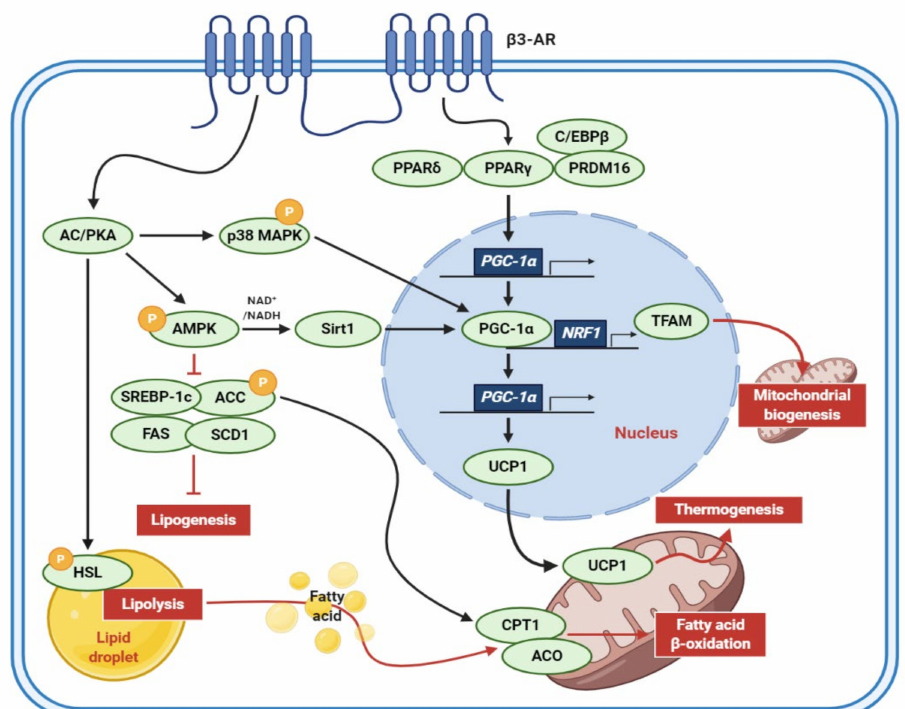
Figure 2. Molecular mechanisms of adipocyte browning. When stimulated by the catecholamines released from terminal neurons, β 3-AR triggers the activation of signal transductions related to lipid catabolism and the browning of adipocytes. β 3-AR, β 3-adrenergic receptors; AC, adenylyl cyclase; PKA, protein kinase A; MAPK, mitogen-activated protein kinase; AMPK, AMP-activated protein kinase; NADH, nicotinamide adenine dinucleotide; Sirt1, sirtuin 1; SREBP-1c, sterol regu- latory element-binding protein 1c; ACC, acetyl-CoA carboxylase; FAS, fatty acid synthase; SCD1, stearoyl-CoA desaturase 1; HSL, hormone-sensitive lipase; C/EBP, CCAAT/enhancer-binding pro- tein; PPAR, peroxisome proliferator-activated receptor; PRDM16, PR/SET domain 16; PGC-1 α , peroxisome proliferator-activated receptor-gamma coactivator-1-alpha; NRF1, nuclear respiratory factor 1-encoding gene; TFAM, mitochondrial transcription factor A; UCP1, uncoupling protein 1; CPT1, carnitine palmitoyltransferase 1; ACO, acyl-CoA